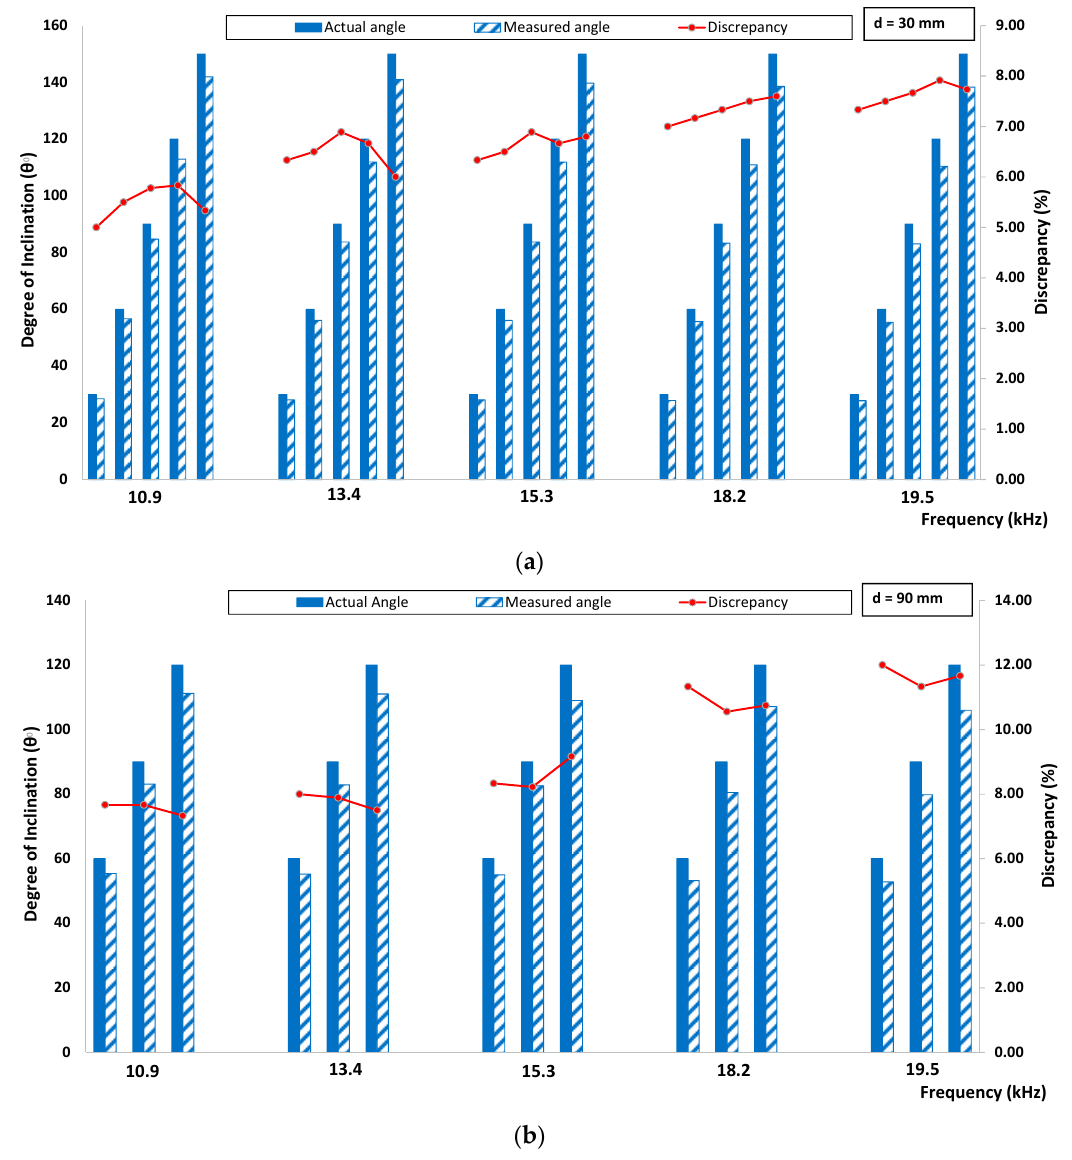
Figure 16. Comparison between actual and experimentally measured degree of inclination based on amplitude index for ( a ) 30 mm crack depth and ( b ) 90 mm crack depth.